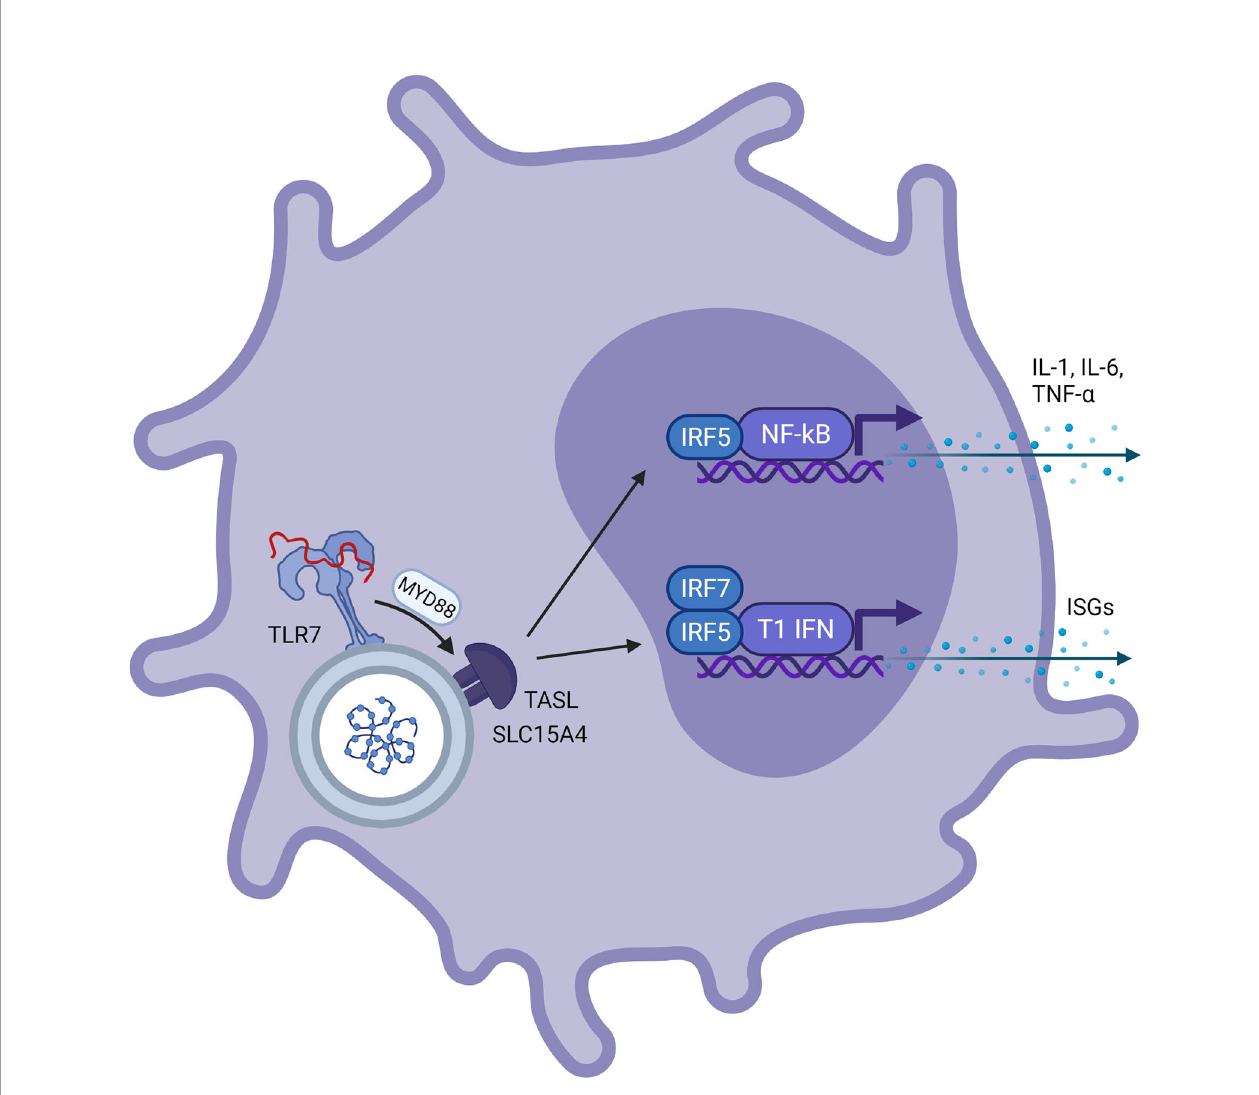
FIGURE 2 | Schematic representation of a plasmacytoid dendritic cell with viral ssRNA in the endosome. This is recognized by TLR7 on the endosomal membrane. Via the MYD88 pathway, ‘ TLR adaptor interacting with SLC15A4 on the lysosome ’ (TASL) is activated which is needed for recruitment of Interferon Regulatory Factor 5 (IRF5), a transcription factor involved in transcription of NF-k b and type 1 interferons. This results in further transcription of IL-1, IL-6 and TNF- a for NF-k b and interferon stimulated genes for type 1 interferons,